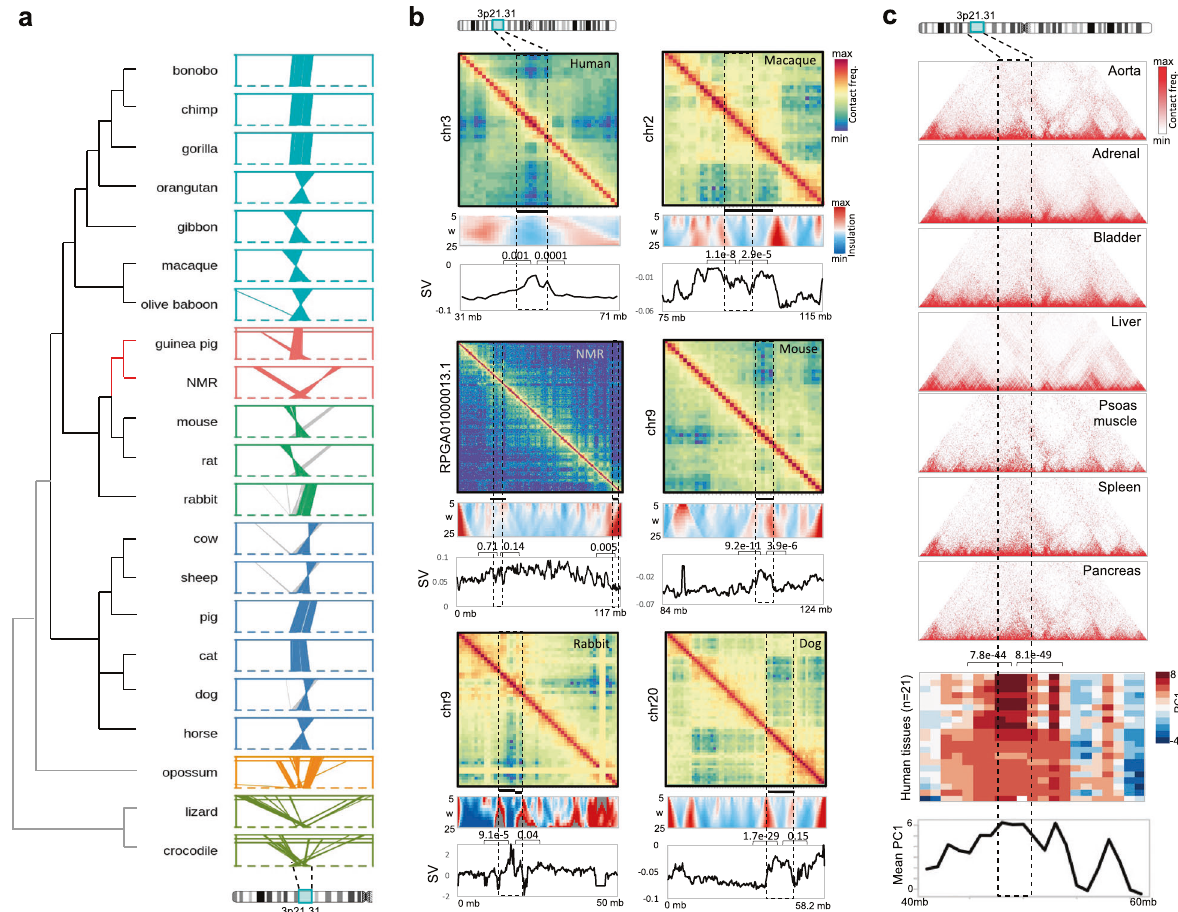
Fig. 3 Linear and spatial synteny of 3p21.31 in placental mammals. a Location of orthologous regions of human 3p21.31 in primates (bonobo, chimp, gorilla, orangutan, gibbon, macaque and olive baboon), rodents (guinea pig, naked-mole rat, mouse and rat), lagomorph (rabbit), artiodactyls (cow, sheep, pig), canines (dog and cat), perissodactyl (horse), marsupial (opossum) and reptiles (lizard and crocodile). Mouse and rat showed an independent split of a small terminal region of 3p21.31 (grey coloured). This region was outside the tumour- suppressor cluster of 25 genes. b Hi-C contact maps (1 Mb resolution), domainograms of insulation scores (200 kb resolution), and leading singular vectors (SV, 200 kb resolution) of 3p21.31 and adjacent regions in the liver of human, macaque, NMR, mouse, dog and rabbit. Black coloured bars above domainograms indicate TAD(s) overlapping with 3p21.31. P values were calculated for the difference of values within 3p21.31 and the adjacent regions of the same length using two-tailed unpaired t tests. c Hi-C contact maps (40 kb resolution), compartment scores (leading principal component as per Schmitt et al. 130 ) of 3p21.31 and adjacent regions across different human tissues. P values for the difference of values within 3p21.31 and the adjacent regions of the same length were calculated using two-tailed unpaired t tests. Effect